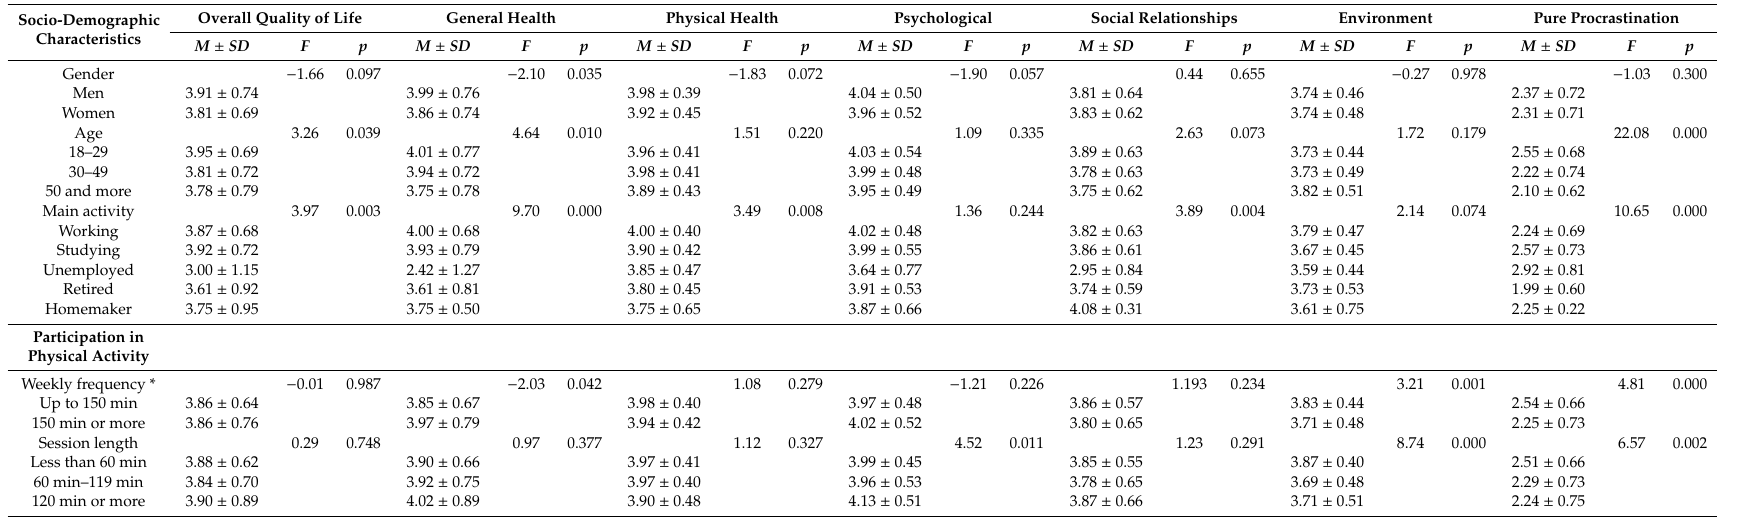
Table 2. Descriptive statistics for domains related to quality of life and pure procrastination, with regard to socio-demographic characteristics and participation in physical activity.